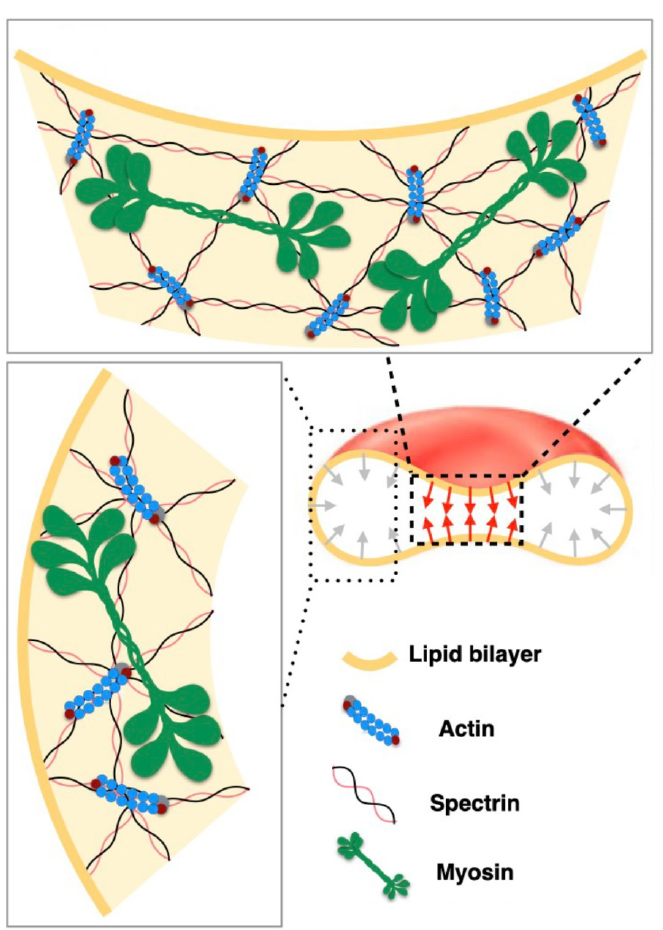
Figure 13. Schematic representation of membrane-myosin interactions in RBC. The shape of the RBC is partially controlled by the interaction of the lipid bilayer and membrane skeleton. Figure shows biconcave discocyte shape of RBC plasma membrane with the membrane skeleton underneath. The myosin (NMIIA) filaments effect (denoted by green colour) was modeled by the local forces applied to the lipid membrane (inward red and gray arrows). Adapted with permission from ref. [49]. 2020 Public Library of